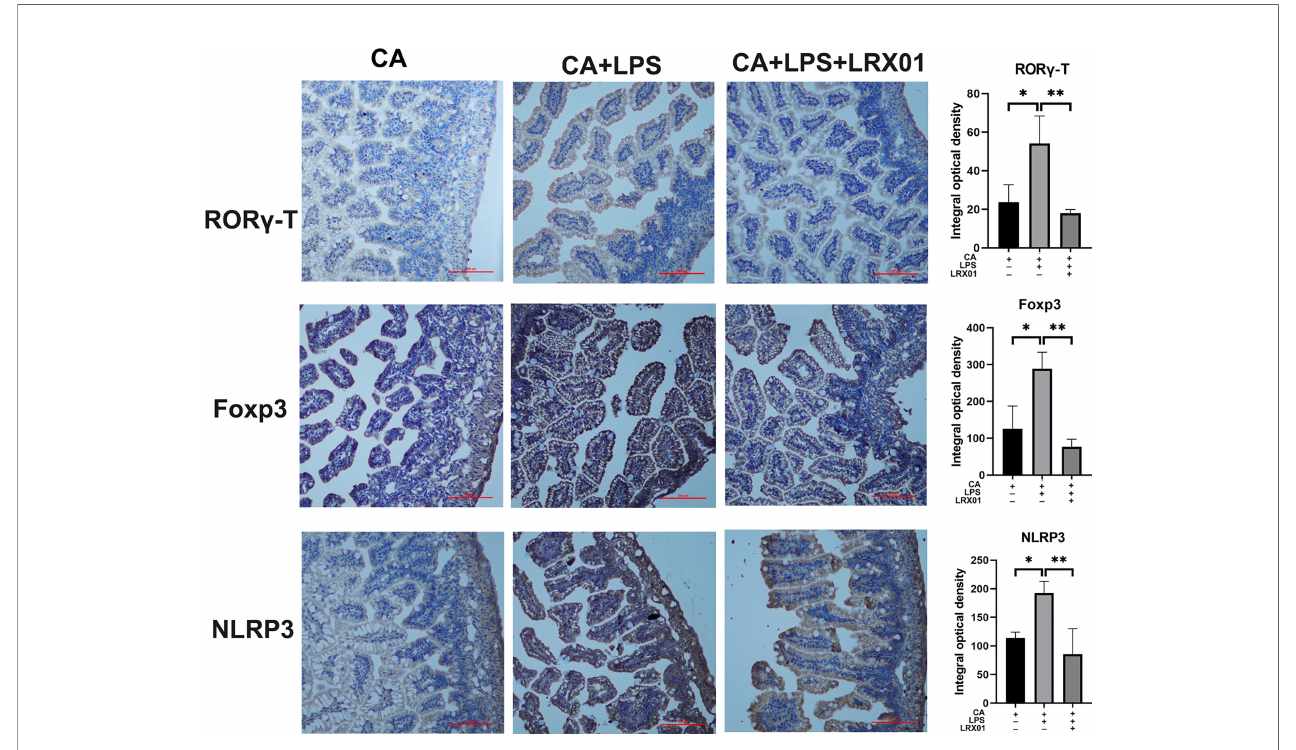
FIGURE 8 | Immunohistochemical staining for ROR g -T, Foxp3, and NLRP3 of ileum treated with LRX01. *p < 0.05, **p < 0.01.